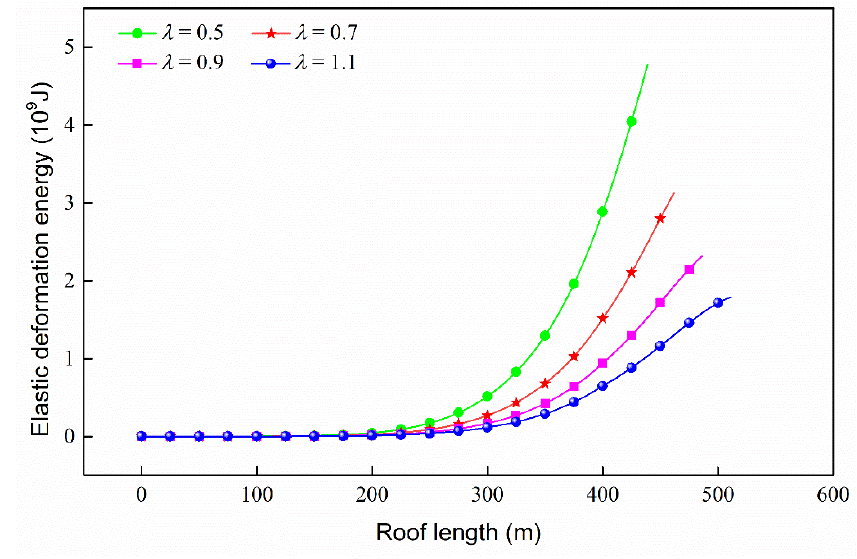
Figure 8. Variation law of the EDE of a roof with different lateral pressure coefficients.